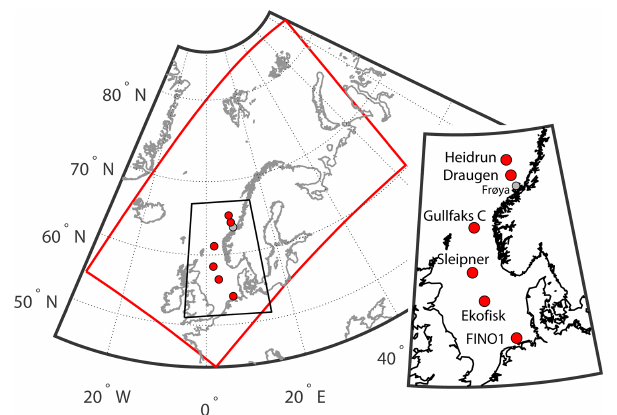
Figure 1. The domain (red rectangle) covered by the HARMONIE- AROME simulation and the locations of the six sites used in veri- fying the NORA3 data set (red dots), in addition to the meteorolog- ical mast located at Frøya. A close-up plot of the positions and the names of the stations is also shown. Details for the sites are given in Table